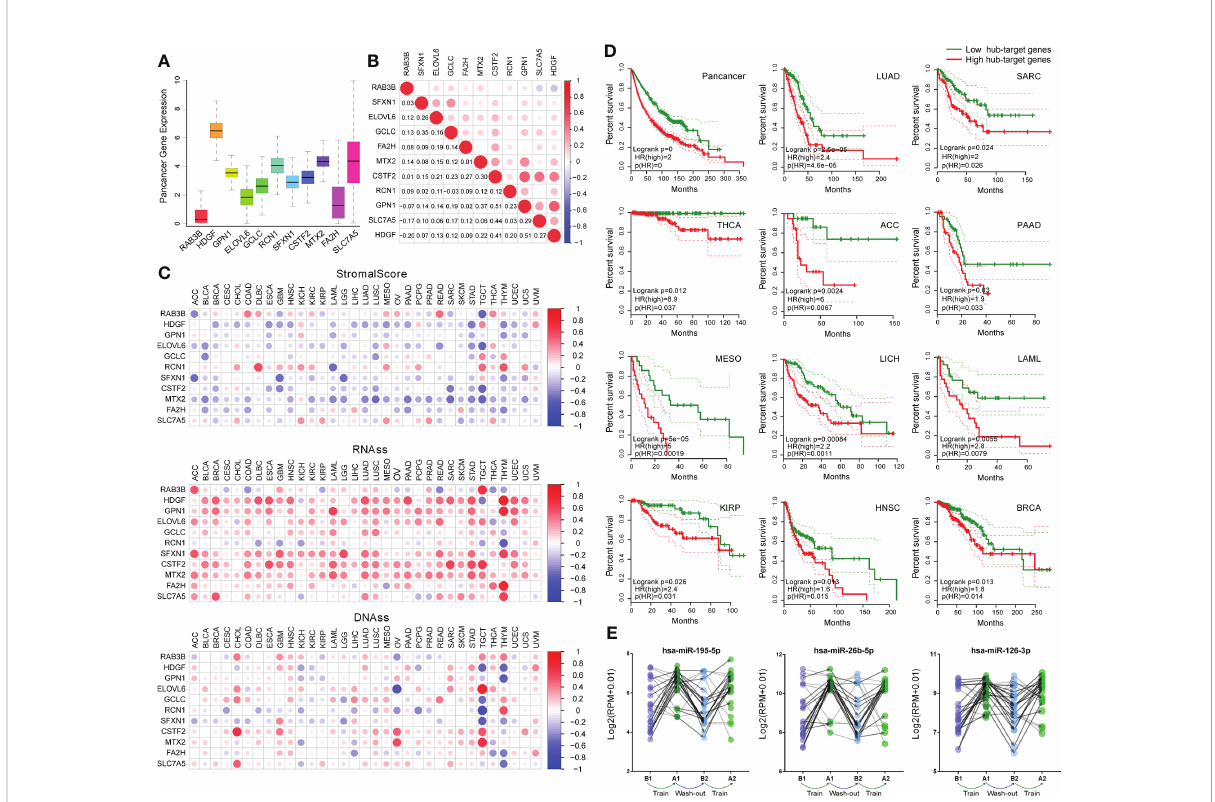
FIGURE 6 Correlation of hub-genes with cancer pathology and prognosis. (A) Boxplot shown the expression of hub-genes across pan-cancer in TCGA. (B) Correlation plot based on Spearman test shown the relationship of hub-genes expression across pan-cancer. (C) Correlation matrix plots shown the association between hub-genes expression and stromal scores (based on ESTIMATE algorithm), as well as cancer stemness scores (RNAss: based on RNA expression, DNAss: based on DNA methylation). The size of the dots represents the value of Spearman test, and the red/blue dots indicate a positive/negative correlation. (D) Kaplan-Meier plots of hub-genes showed differential overall survival outcomes ( p <0.05) across pan- cancer. (E) The expression of core-miRNAs in an exercise dataset (GSE133910). At four time points (B1, A1, B2 and A2) plasma samples were collected. Volunteers completed eight weeks of training, followed by a wash-out phase (eight weeks), and another eight weeks of training analogous to the fi rst